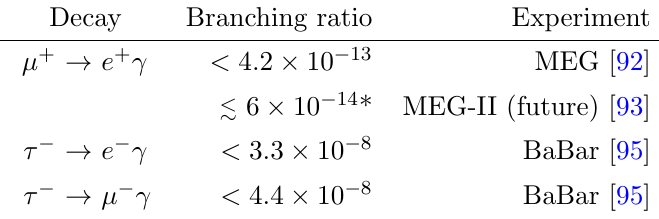
Table 5 . Experimental upper limits on cLFV decays ‘ 1 ! ‘ 2 (cid:13)